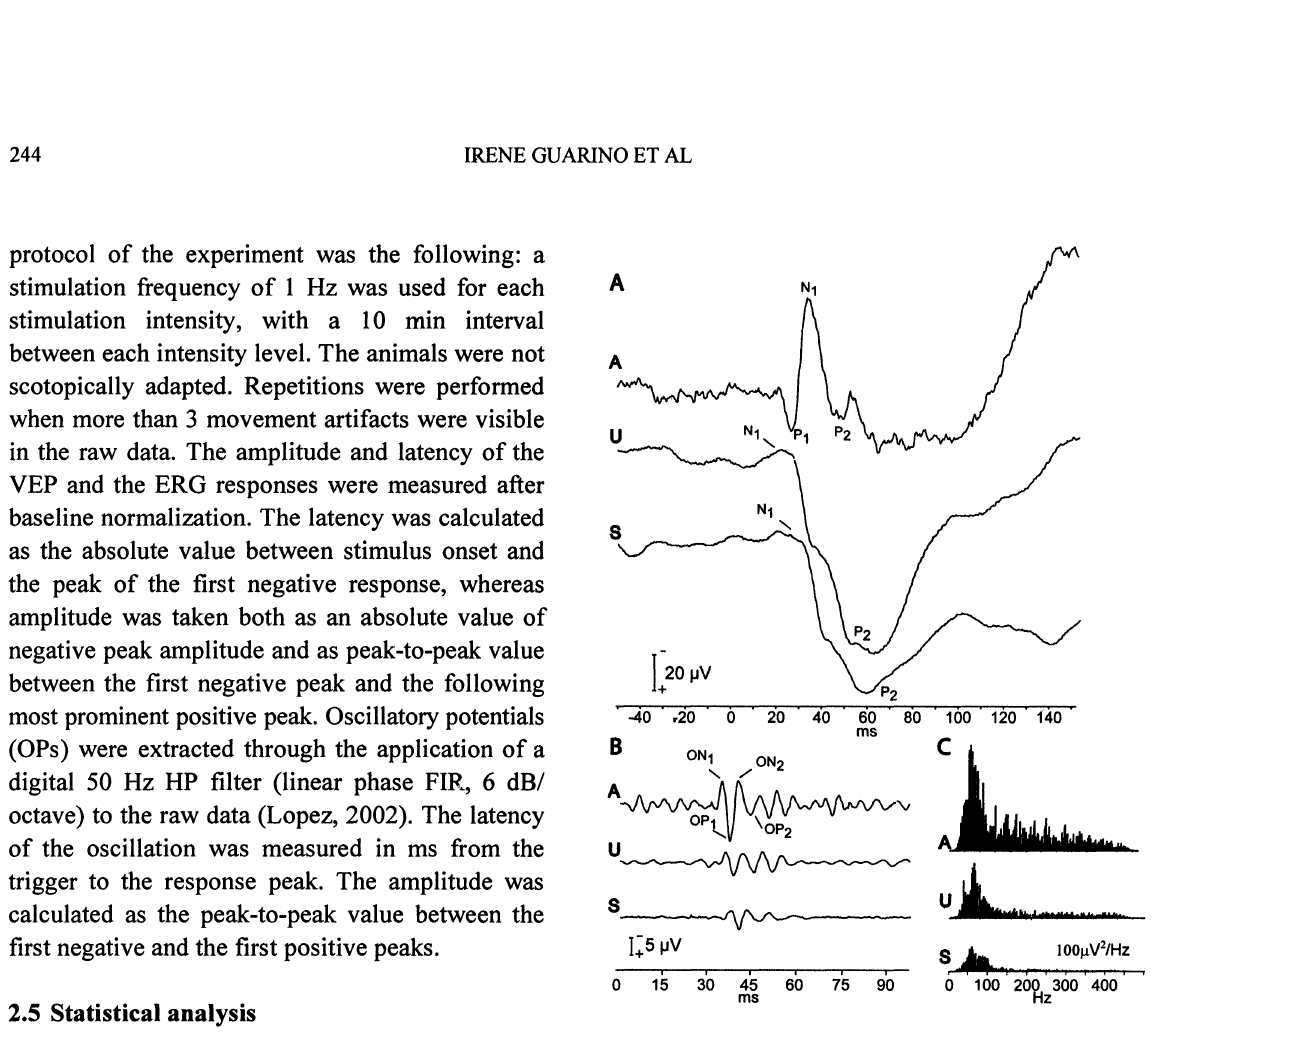
Fig. 2.1 A. Example of VEP in three differem conditions: in awake (A), anaesthetized (U), and treated with scopol- amine (S). Positive and negative peaks labeled as N 1, P2, and N2 characterized baseline awake VEPs. B. Superimposed on peaks, a train of higher frequency positive and negative oscillatory potentials is labeled as ONe, ON2, and OPt, OP2, respectively C. Power spectrum of cortical oscillatory potentials shown in